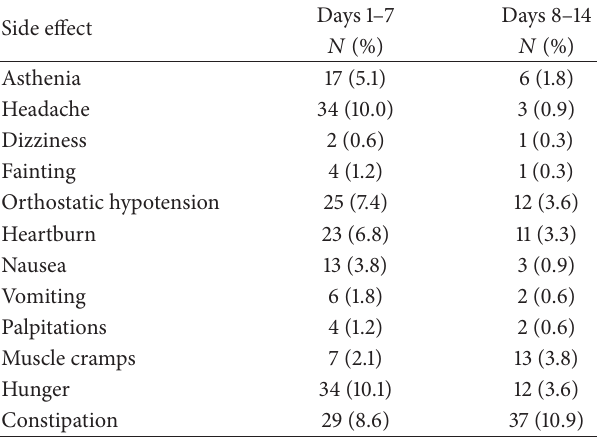
Table 2: Self-reported side effects throughout the study (per- protocol population; 𝑁 = 338